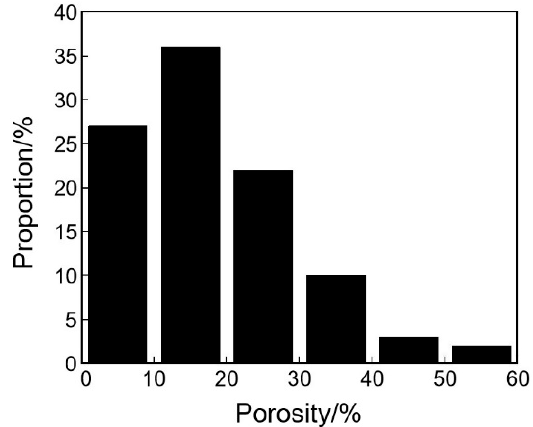
Figure 3. Porosity distribution for the YSZ coating samples.